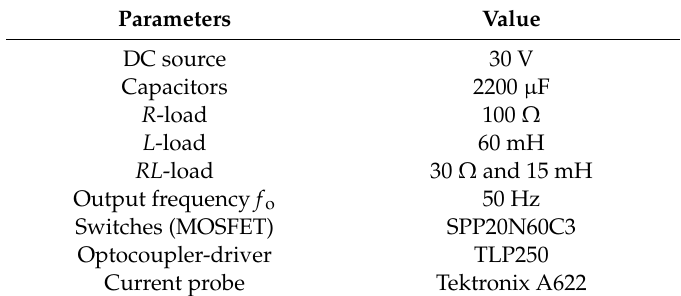
Table 6. Experimental parameters.